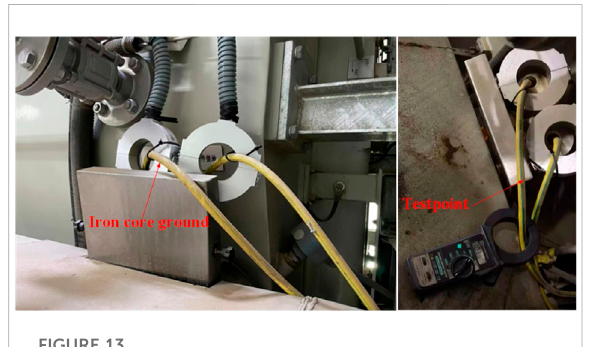
FIGURE 13 Converter transformer core ground point and test point.